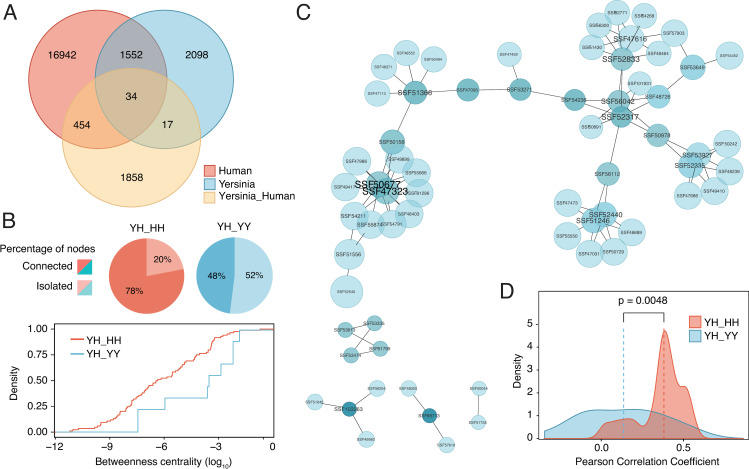
Structural analysis of protein-protein interactions in the Yersinia pestis-Homo sapiens interactome.(A) Venn diagram showing shared and unique domain associations between the Y. pestis-H. sapiens, Y. pestis-Y. pestis and H. sapiens-H. sapiens interactomes. (B) Percentage of isolated and connected nodes in the shared subnetworks (intersection) between the Y. pestis-H. sapiens interactome and the Y. pestis-Y. pestis or H. sapiens-H. sapiens interactomes. Cumulative distribution of betweenness centrality in both subnetworks. (C) Y. pestis-H. sapiens domain association network filtered for Y. pestis proteins that have a high contribution to infection fitness (fitness factor < 0.4). Complexes that involve bacterial proteins with a high contribution to infection fitness were modeled and docked to obtain the putative three-dimensional structure. (D) Distribution of Pearson correlation coefficients in the filtered network of contacts for all modeled complexes (n = 18). For all amino acids the connectivity matrix and Pearson correlation coefficients were calculated. The plot shows the distribution of correlation coefficients for each amino acid in YH complexes against HH and YY complexes.